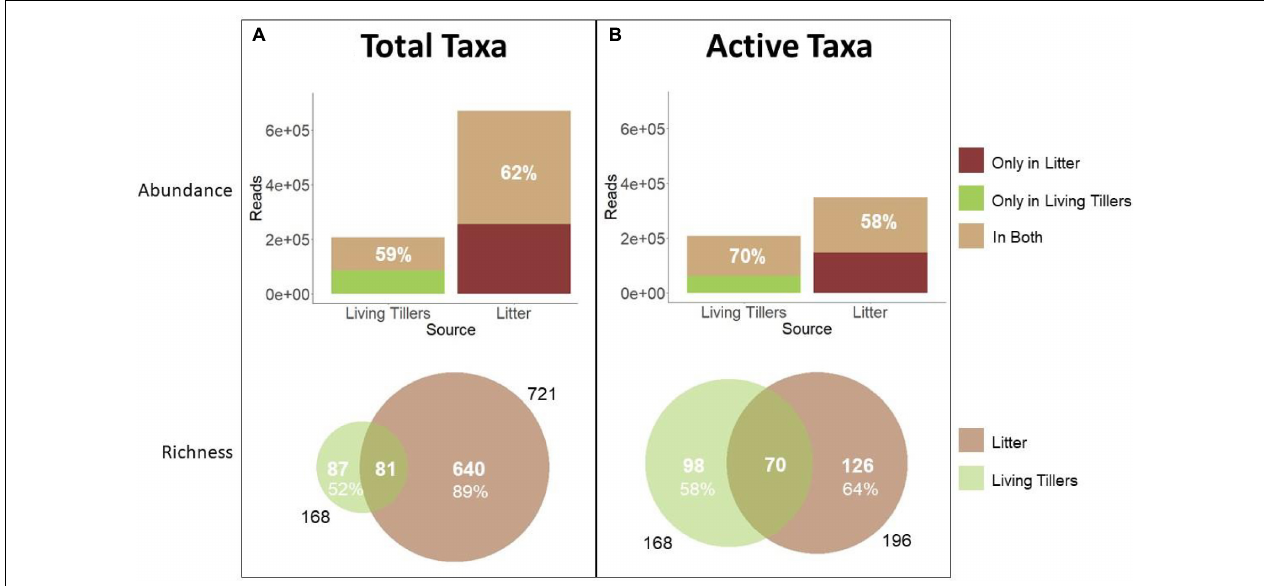
FIGURE 3 | Abundance and richness of saprophytic fungi in living and senescent tillers. Comparison between the endophyte community and (A) the total litter community or (B) the active litter community. Sequence read abundance and OTU richness of latent saprophytes in living tillers (olive; n = 8 samples) and of saprophytes in dead litter (brown; n = 18 samples) is based on NGS